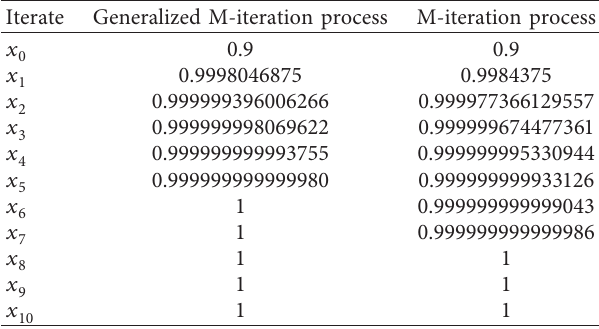
Figure 1: Convergence of an iterative sequence generated by generalized M-iteration process. Table 2: Sequences generated by generalized M-iteration process and M-iteration